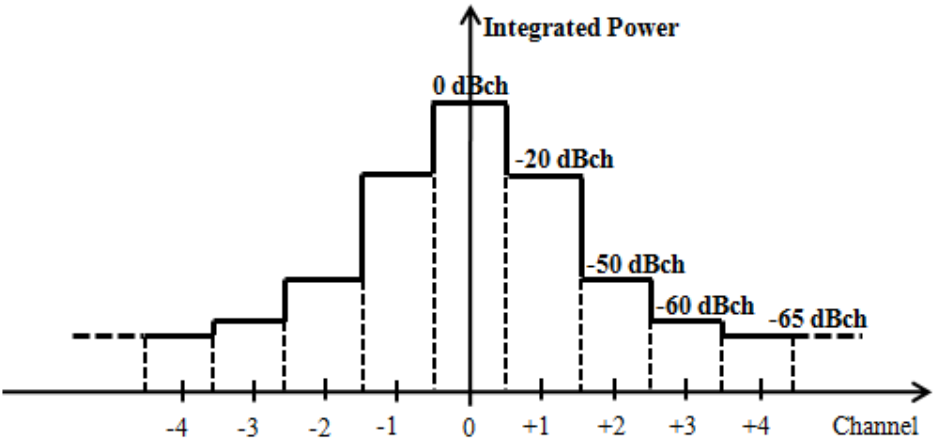
Figure 2. Spectral mask of a channel